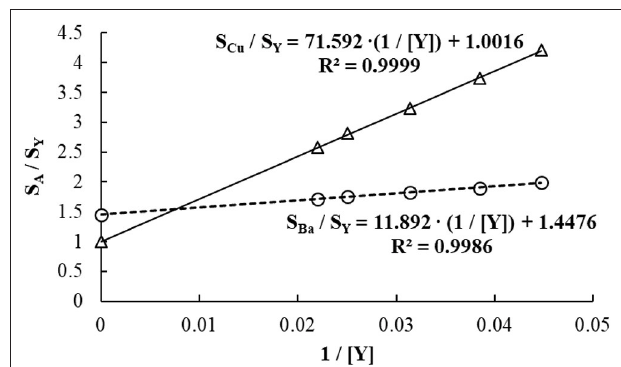
FIGURE 5 | Calibration plots created from the SDA region (negative slopes) in Figure 4 . The concentrations of Ba, Cu, and Y added to S1 were 50 µ g/L